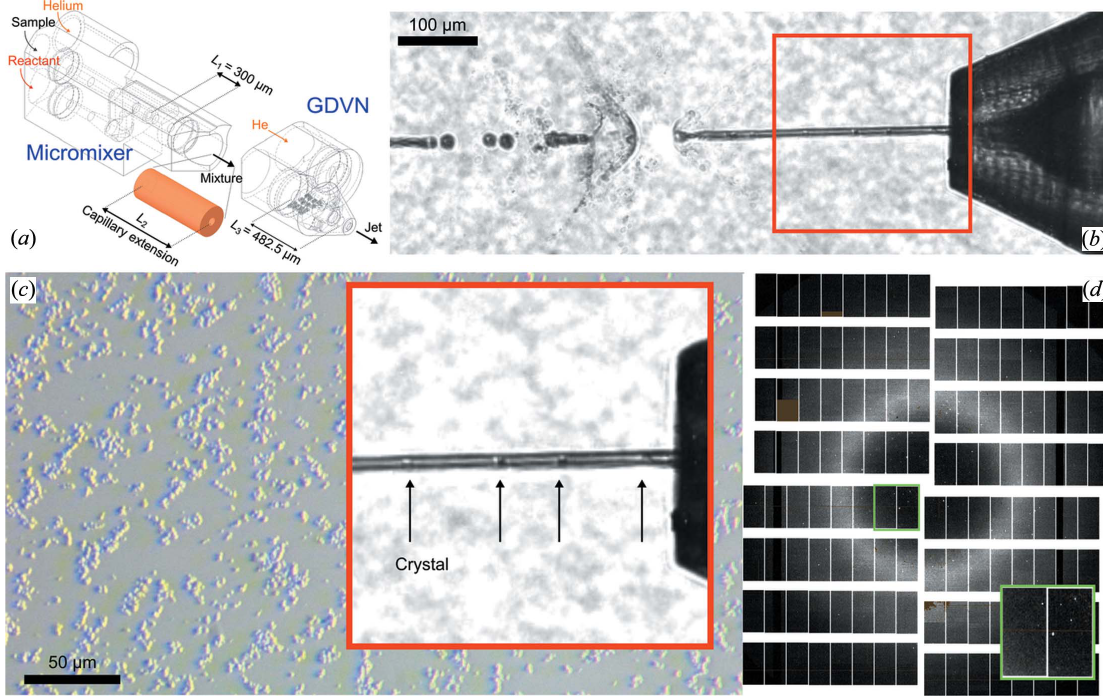
Figure 2 ( a ) An overview of the 2PP-3D printed mix-and-inject device ( i.e. mixing-GDVN) consisting of a micromixer, a GDVN (type C) and a connective capillary in between. The capillary extension was chosen to be L 2 = 28 mm. ( b ) A microscopy image showing lysozyme crystal delivery on the SPB/SFX instrument (10 (cid:6) magnification, NA 0.28, pixel size (cid:7) 0.65 m m). Upstream from the depicted X-ray interaction region, the crystals enter from the main channel of the mixing device at 7 m l min (cid:4) 1 and are flow-focused by pure water entering from the side channel at 70 m l min (cid:4) 1 . Downstream, the 11-fold diluted sample then enters the GDVN (type C, 100 m m liquid orifice). With a helium pressure of 550 psi ( Q g = 34 mg min (cid:4) 1 ), a liquid jet of 7.5 m m in diameter delivers the crystals into the X-ray focus. With our prediction formula [Fig. 4( b )], the jet velocity was determined to be 30.5 m s (cid:4) 1 . ( c ) A microscopy image of the lysozyme crystal dispersion from the utilized sample reservoir showing the near-monodisperse microcrystals. ( d ) A background- corrected detector image of lysozyme diffraction from the same 11-fold dilution collected on the AGIPD 1M detector. The detector (pixel size is 200 m m (cid:6) 200 m m) consists of four movable quadrants, each quadrant consisting of four static independent modules. Each module is 26 mm (cid:6) 103 mm (128 (cid:6) 512 pixels) large and consists of 2 (cid:6) 8 ASICs (application-specific integrated circuits). The magnified region (green rectangle) shows Bragg reflections within 2 (cid:6) 2